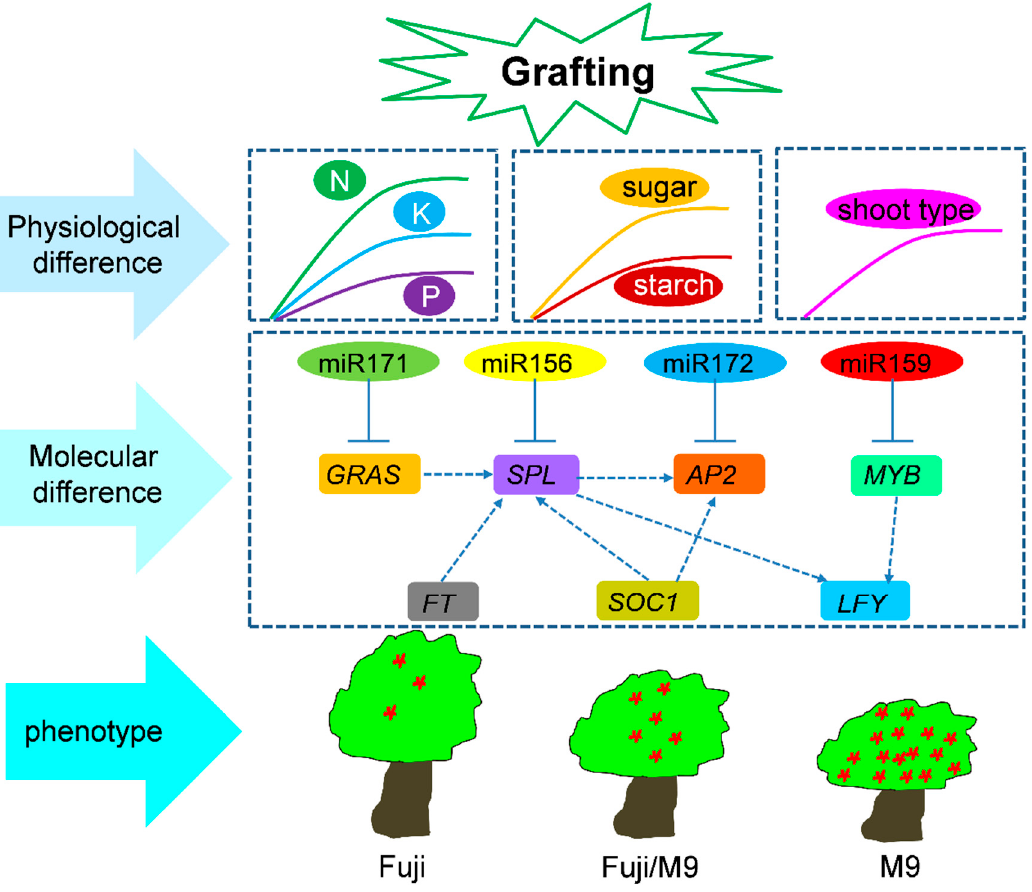
Figure 10. Hypothetical model for critical regulatory networks in response to grafting processes between scions and rootstocks in Malus .